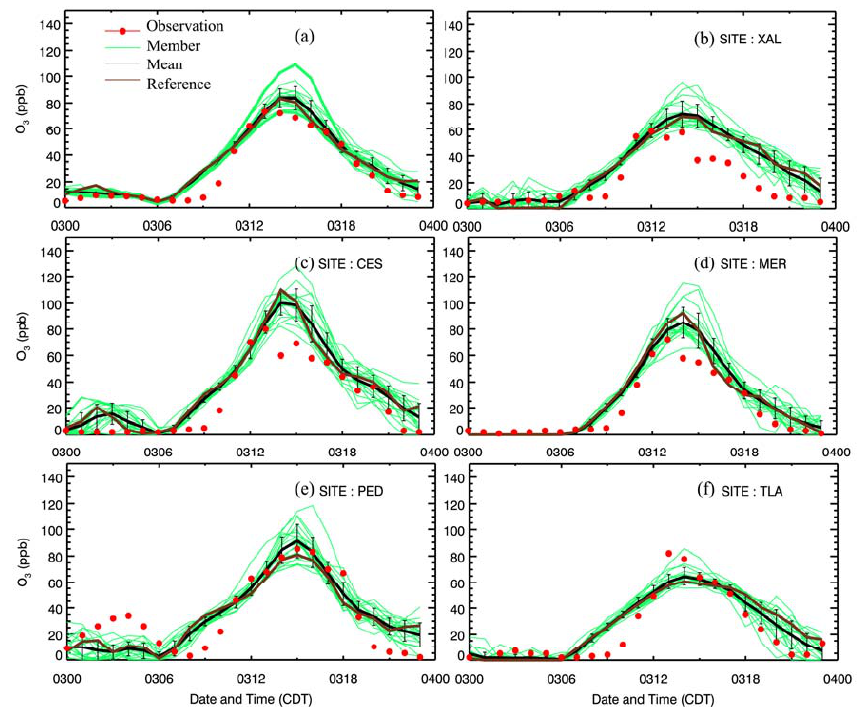
Fig. 5. Temporal evolution of surface [O 3 ] (ppb) from each ensemble member (thin green lines), ensemble mean (bold black line) and reference deterministic forecast (bold orange line) of the CTRL ensemble simulation (3 March 2006) and observations (red dots) for values (a) averaged over the RAMA sites and (b–f) at the 5 selected stations (TLA, XAL, MER, PED, and CES, shown in Fig. 1b). The error bars denote the ensemble spread. Bold green lines in (a) indicate two extreme cases (low ozone case: EN-11 and high ozone case: